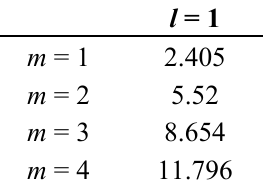
Table 1. Values for the mode parameter u